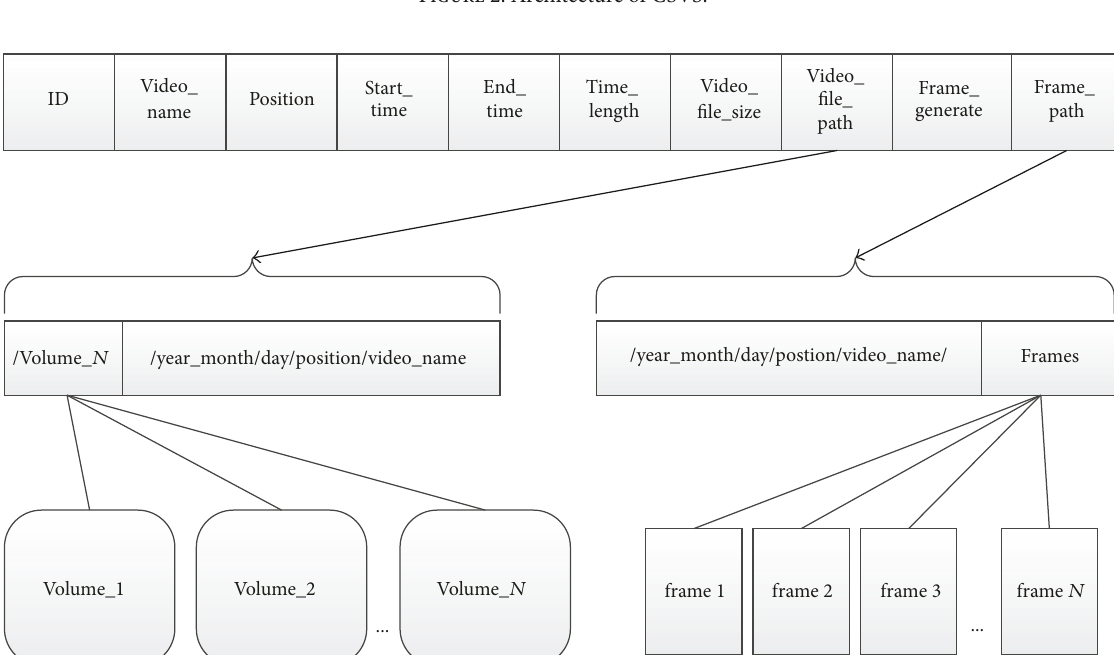
Figure 3: Metadata